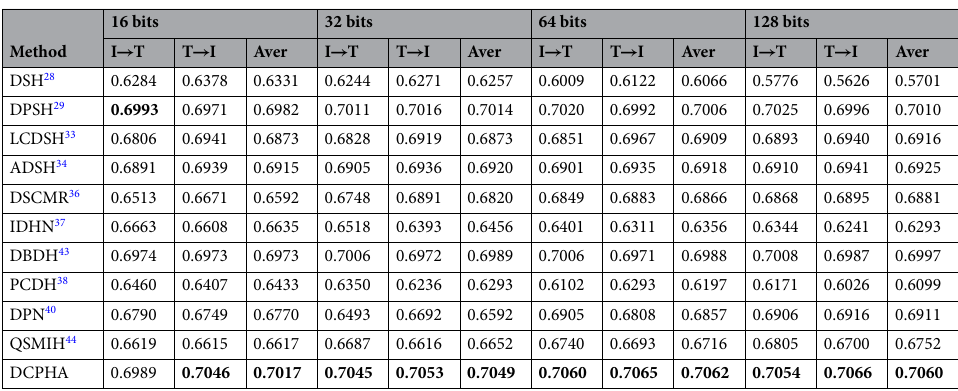
Table 5. The mAP scores of cross-modal retrieval on MIRFLICKER25K with different lengths of hash codes. Best Performance in Bold.